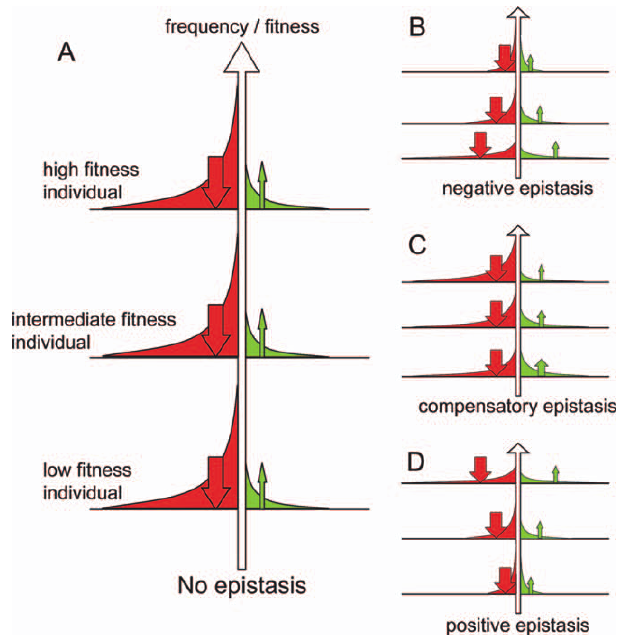
Figure 1. Changes in Mutational Distributions Due to Epistasis The distribution of deleterious mutations appears in red, beneficial mutations in green. Arrows indicate the mean mutational effect; the width of the arrow reflects the rate of deleterious or beneficial mutations. (The total mutation rate remains constant.) Three mutational distribu- tions are illustrated for each epistatic context: individuals of high, intermediate, and low